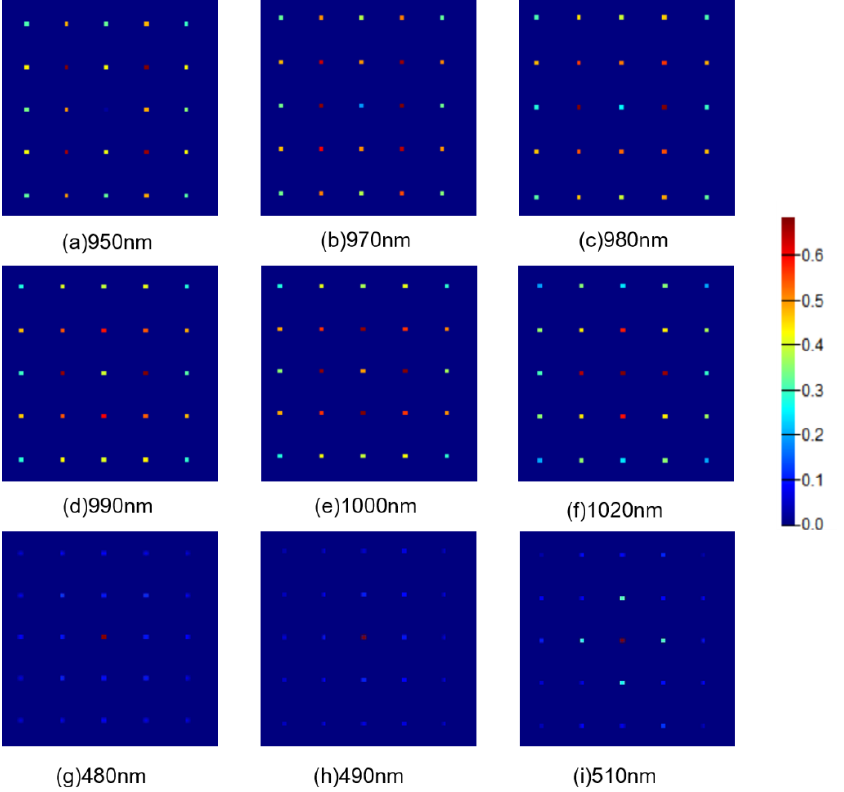
Figure 11. ( a – i ) Normalized light intensity distribution of the diffraction spots when plane waves with different wavelengths are incident.